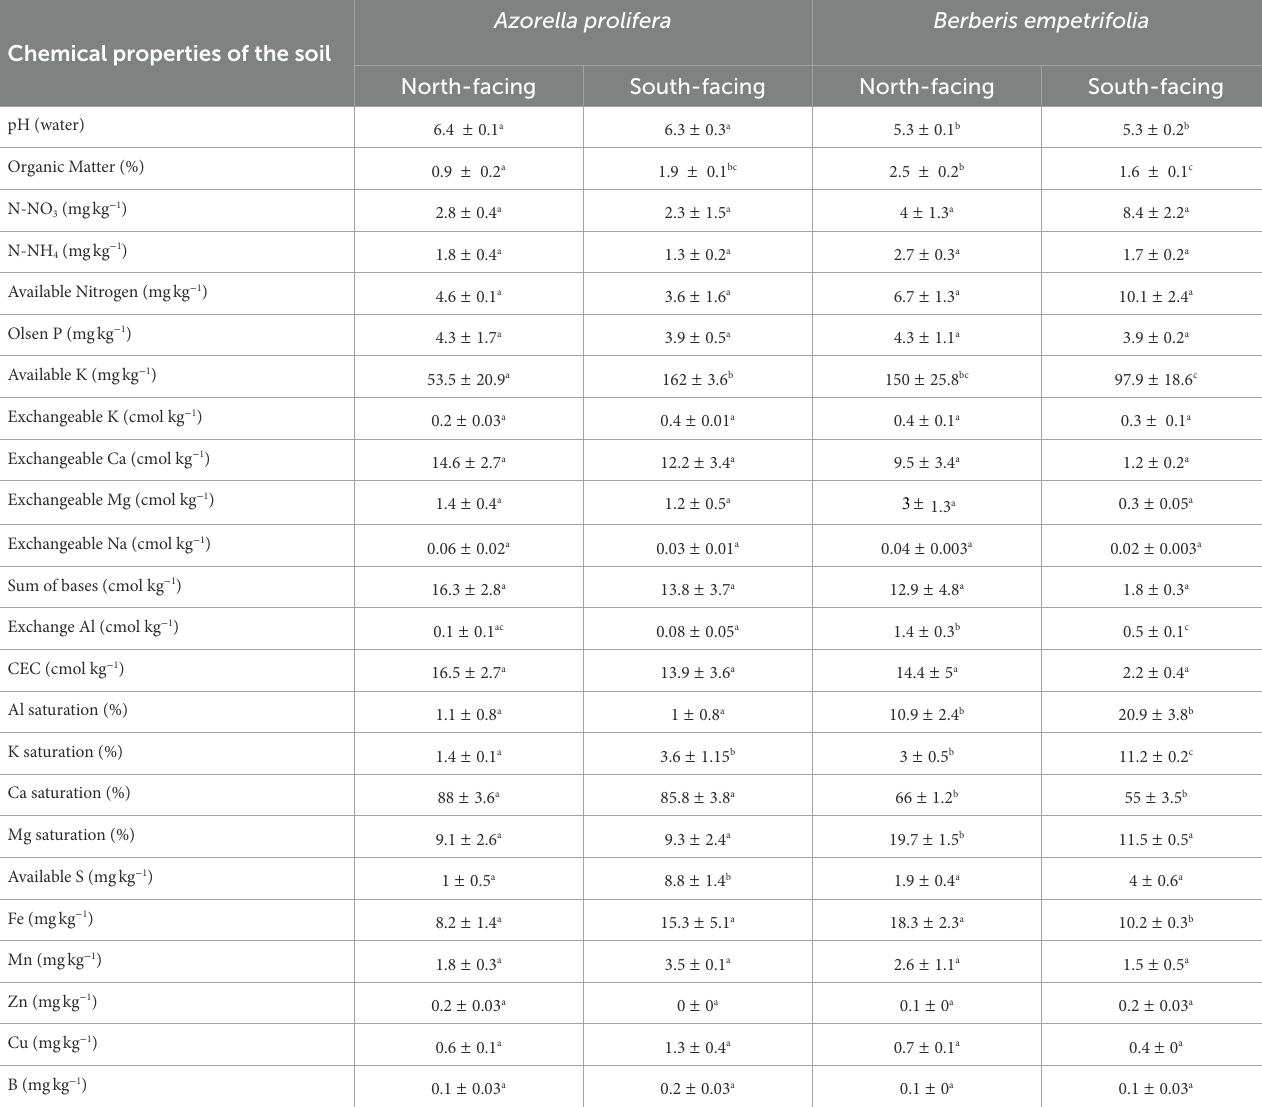
Values correspond to average ± SE ( n = 3). Different lower-case letters indicate significant differences ( p < 0.05).